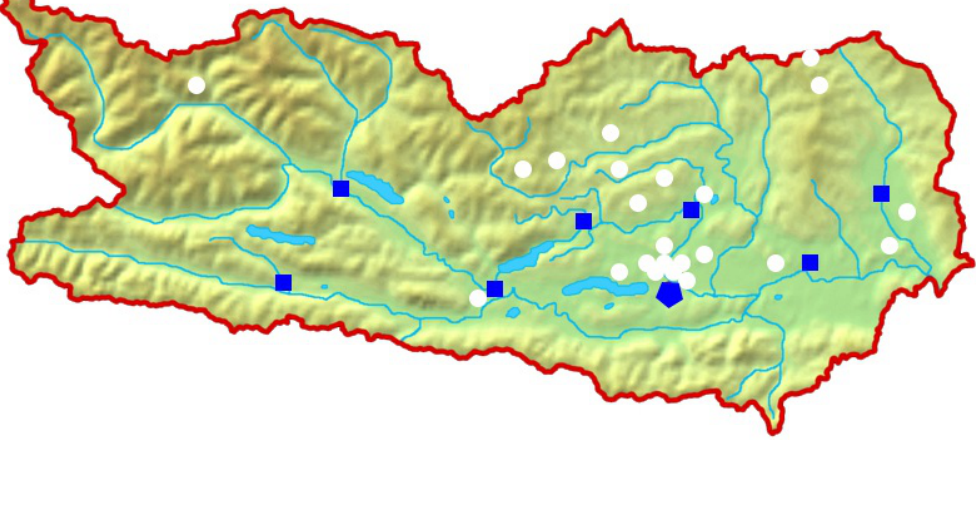
Figure 1. Topographic distribution of participating households. The white circles represent the participating households. The blue rectangles represent the bigger cities in Carinthia (ranging between 10,000 and 60,000 inhabitants); the polygon shows the location of the university (where the server infrastructure is hosted) in the capitol of Carinthia (which has around 100,000